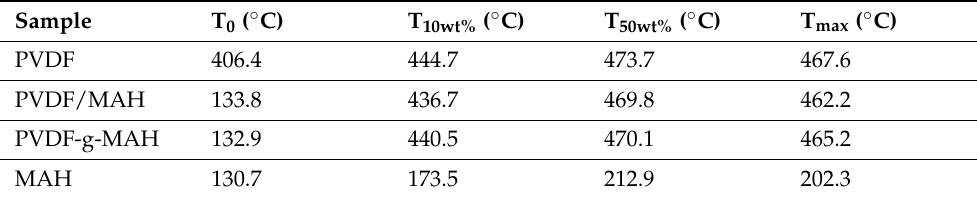
Figure 7. TGA curves of pure PVDF, PVDF/MAH and PVDF-g-MAH (G = 0.63%) under a nitrogen atmosphere: ( a ), TG; ( b ), DTG. Table 2. TGA data for PVDF, PVDF/MAH and PVDF-g-MAH.